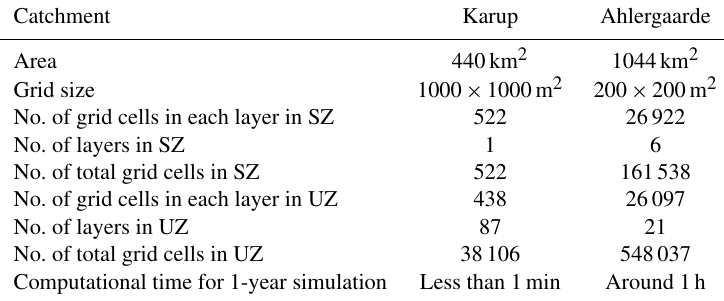
Table 1. Differences in model resolution and computation time between the two catchments. SZ refers to the saturated zone and UZ to the unsaturated zone; the term “No. of” means “Number